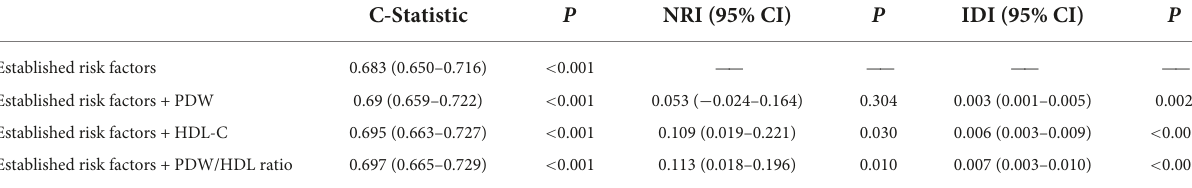
TABLE 6 Evaluation of predictive models for